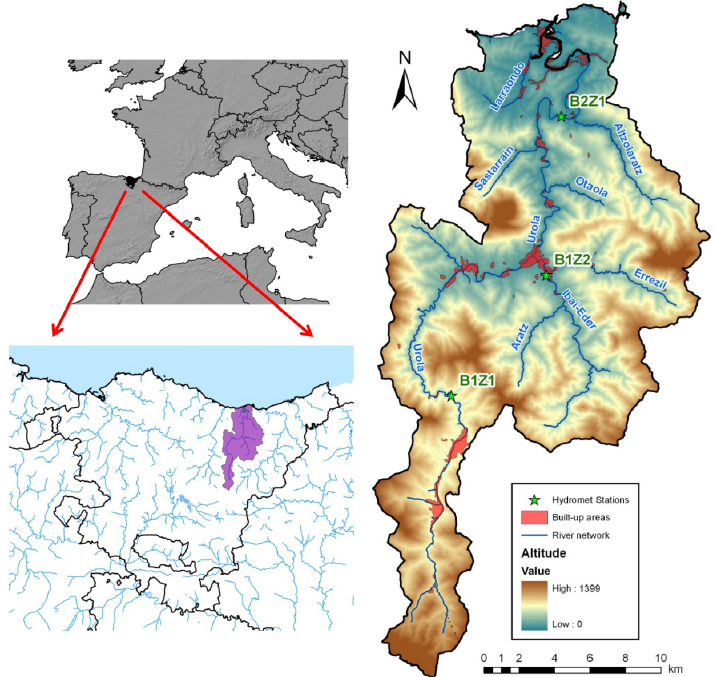
Fig. 10. Location of the Urola catchment and gauges used to calibrate the distributed catchment model in the validation of the stochastic